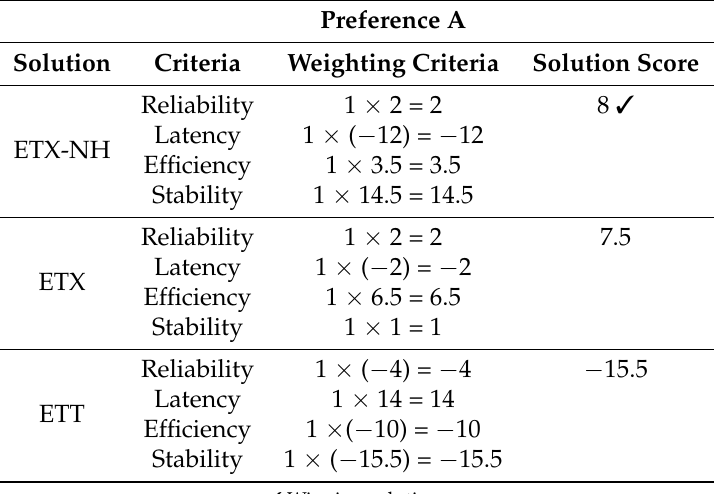
Table 6. Solution scores after weighting for preference A.